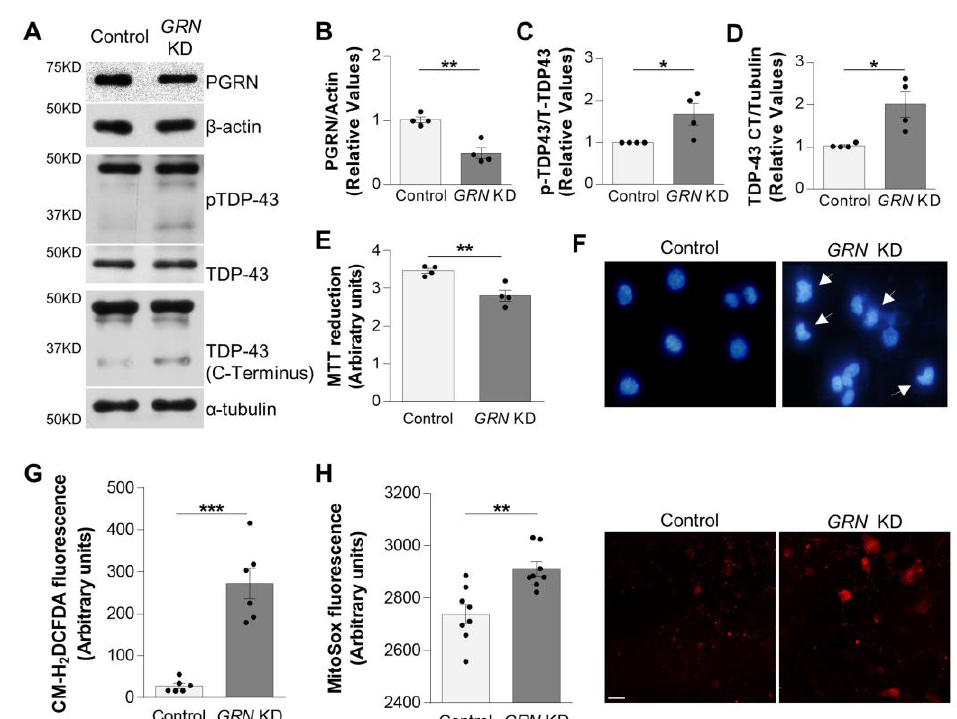
Figure 1. PGRN insufficiency induces TDP-43 pathology, apoptotic cell death and oxidative stress in SH-SY5Y cells. ( A – D ) Representative immunoblots and quantification showing that GRN KD SH-SY5Y cells exhibited increased TDP-43 phosphorylation at S409/410 residues and accumulation of C-Terminal fragments of TDP-43 protein. Plots represent the average ± SEM of the protein levels in four independent experiments. ( E ) Control and GRN KD SH-SY5Y cells were seeded in triplicate at same confluency (50,000 cells/well) on 96-well plates. Then, 72 h after seeding, cell viability was measured using MTT colorimetric assay. Plot represents the average ± SEM of four independent experiments. ( F ) Control and GRN KD SH-SY5Y cells were seeded at the same confluency on glass coverslips and 72 h later the apoptotic cell death was assessed by visualizing pyknotic nuclei (white arrows) using DAPI staining and fluorescence microscopy. ( G ) Control and GRN KD SH-SY5Y cells were seeded in triplicate at the same density in 96-well plates (50,000 cells/well) and 72 h